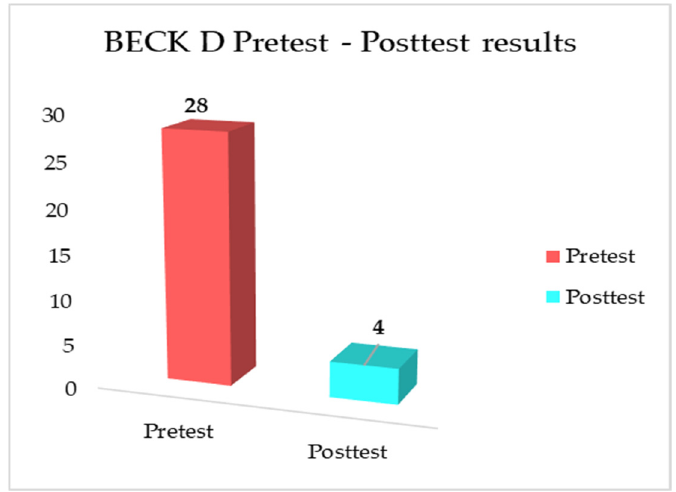
Figure 2. Comparisons of the BDI pretest-posttest results.